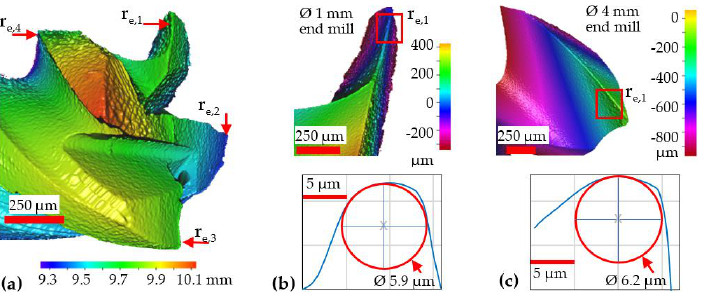
Figure 2. ( a ) Sample 3D scan of tool surface highlighting the measured cutting-edge radii, with cor-